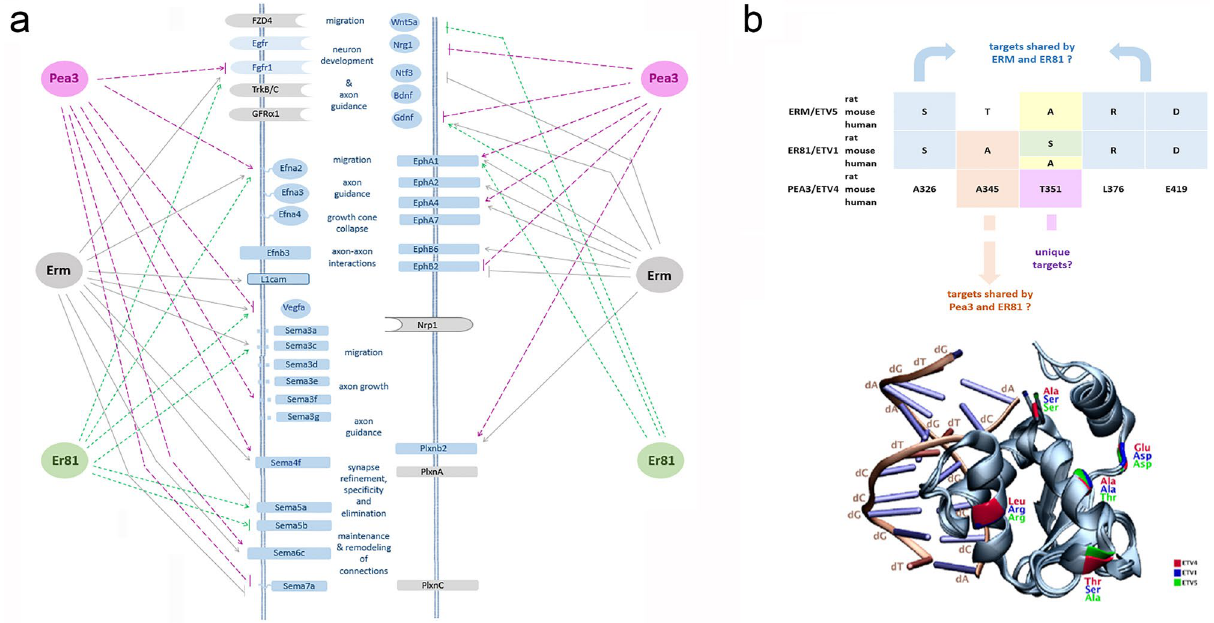
Figure 7. ( a ) Schematic model of selective regulation of a subset of cell surface proteins involved in migration, neuron development, axon guidance and other pathways by Pea3 family members. Not every regulation is depicted for the sake of simplicity; where a family member can activate or repress the indicated target depending on the cellular context, both regulations have been shown simultaneously. Pea3 regulations were shown as dashed pink lines and arrows, Erm regulations were shown as grey lines or arrows, and Er81 regulations were shown as green dotted lines or arrows. Those cell surface molecules that were experimentally shown to be regulated by Pea3 family members appear as blue shapes, whereas known interaction partners that have not been shown to be regulated by Pea3 family members appear as grey shapes. ( b ) Schematic